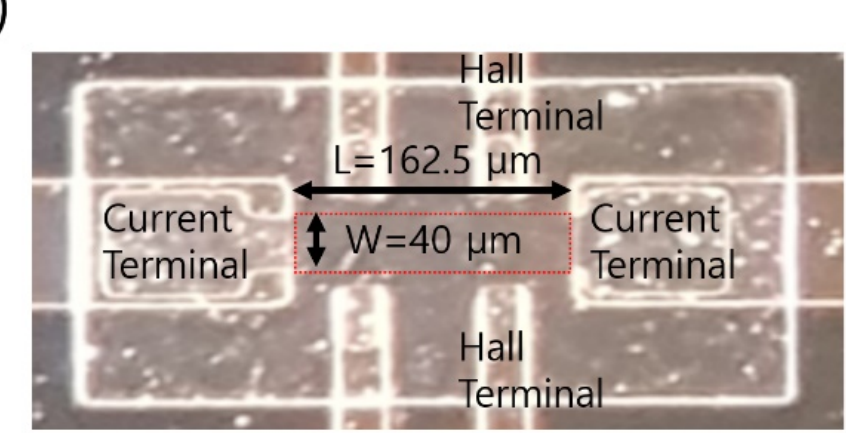
Figure 1. ( a ) Schematic of the a-IGZO Hall bar TFT without the top SU-8 passivation layer. The